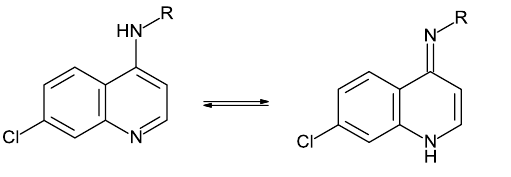
. . . tautomer I (amino) tautomer II (imino)